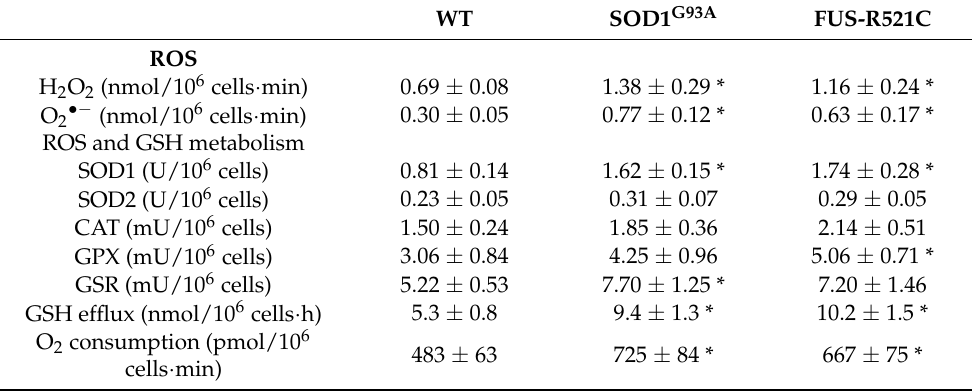
Table 8. ROS generation and GSH efflux in astrocytes isolated from wild-type and ALS mice. All parameters (see Methods) were determined in astrocytes isolated from wild-type or ALS mice at an advanced state of progression. Data are mean values ± SD for n = 9. * p < 0.01 comparing values obtained in ALS models versus wild-type